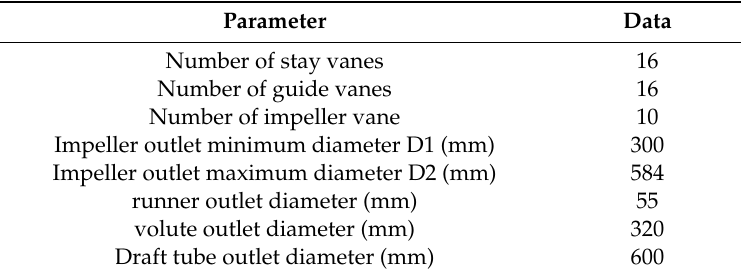
Table 1. Basic parameters of the pump-turbine